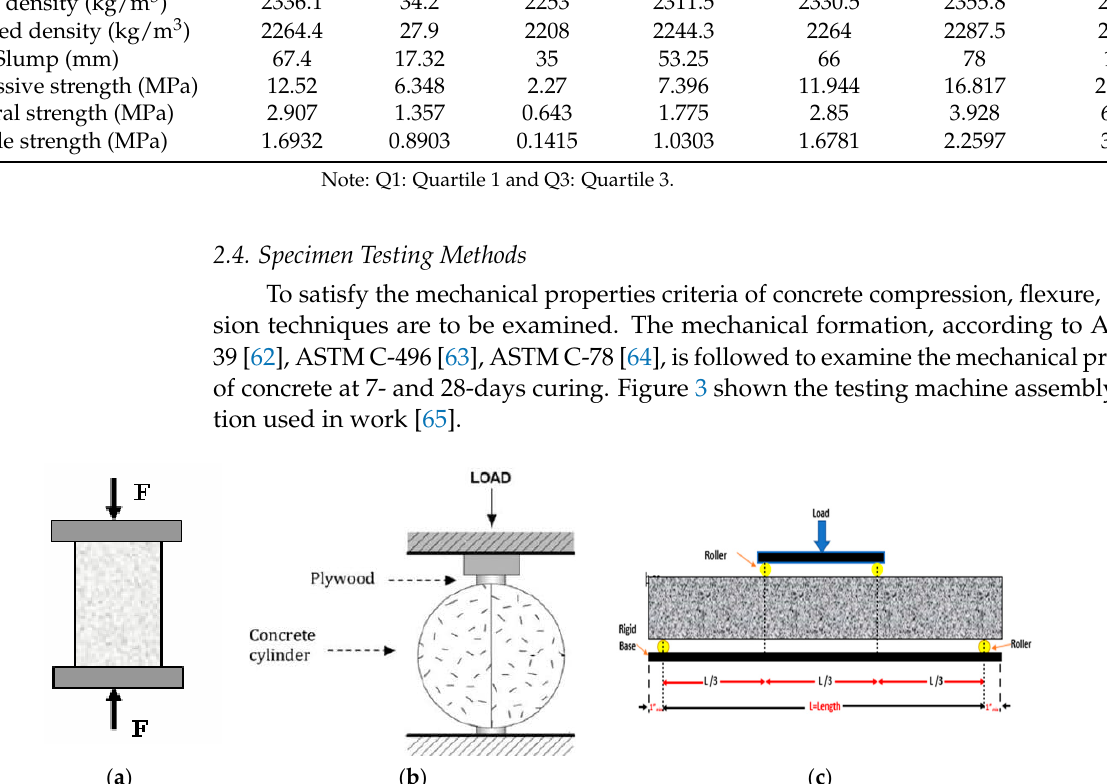
Table 4. Descriptive statistics data of eco-friendly rigid pavement green concrete.